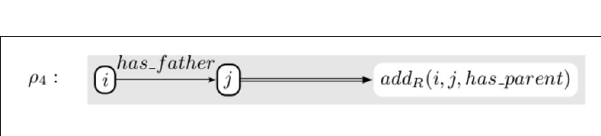
FIGURE 8 | A rule that adds the fact that has _ father ⊆ has _ parent